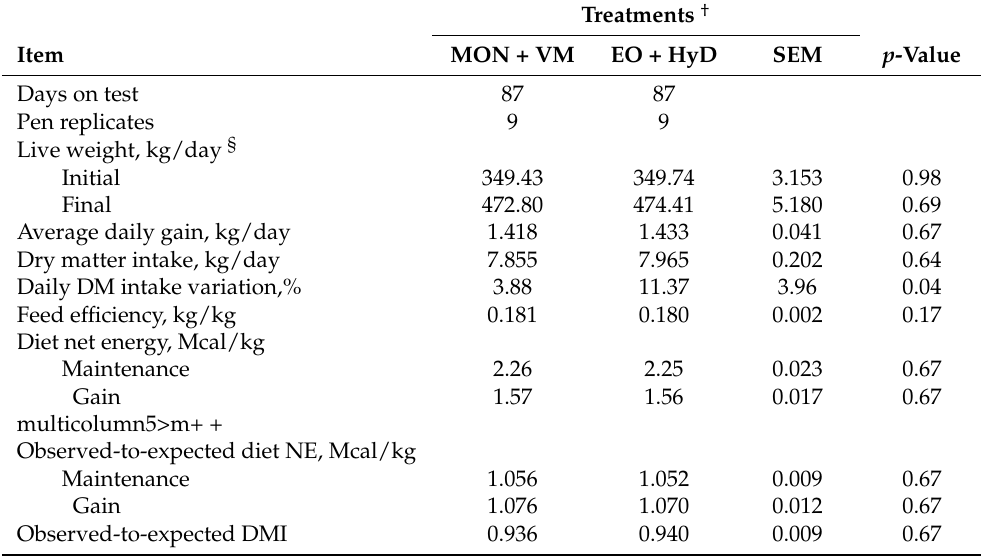
Table 2. Effect of treatments on growth-performance and dietary energy of finishing cattle.